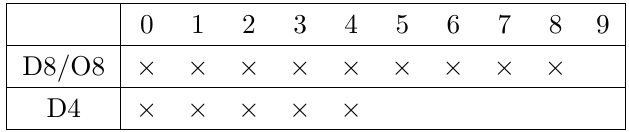
Table 1. The D4-D8/O8 brane system in type I’ string